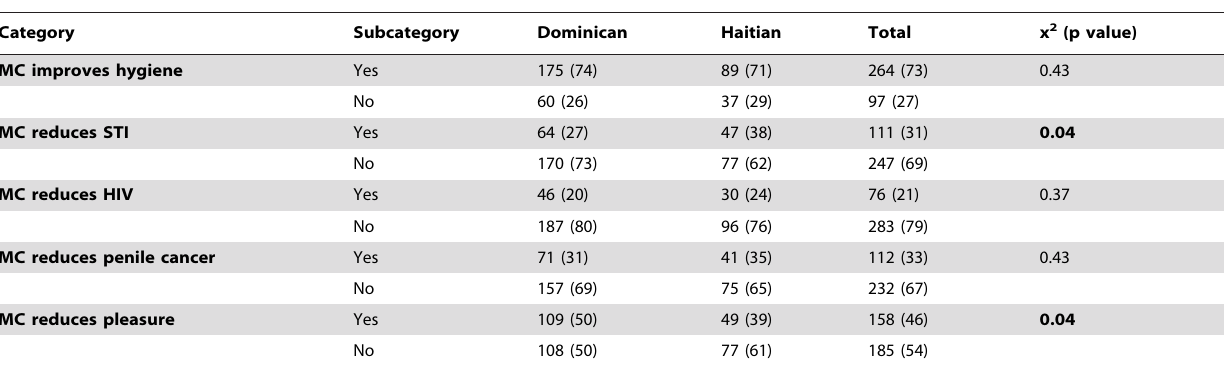
Table 2. Perceived benefits of circumcision by national origin.